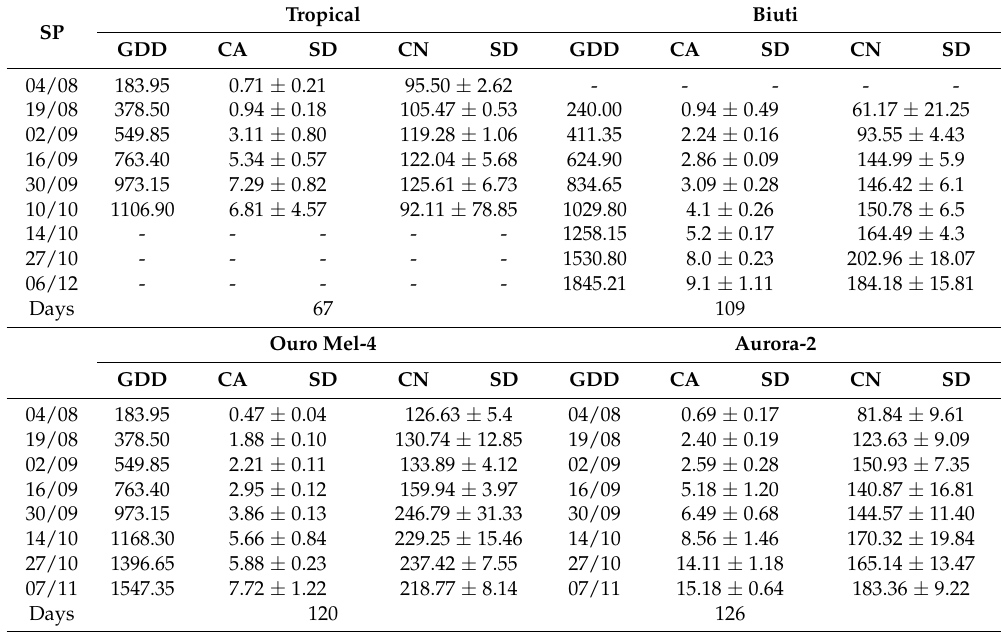
Table 2. Sampling periods (SP), accumulation of growing degree-days (GDD) from the date of full bloom (FB) to fruit senescence, average cell area (CA) in µ m 2 and average cell number of mesocarp (CN) for the cultivars Aurora-2, Ouro Mel-4, Tropical and Biuti, in Lavras, MG, Brazil.